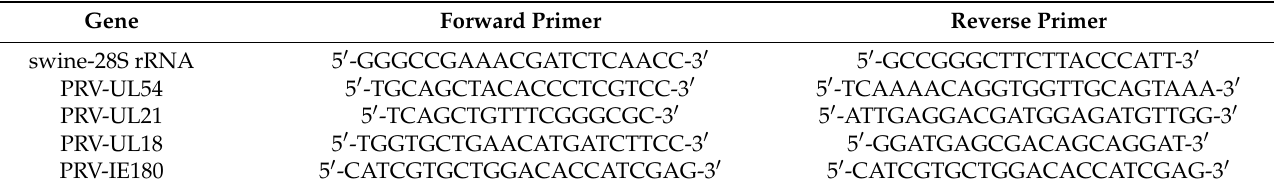
Table 1. qPCR primer